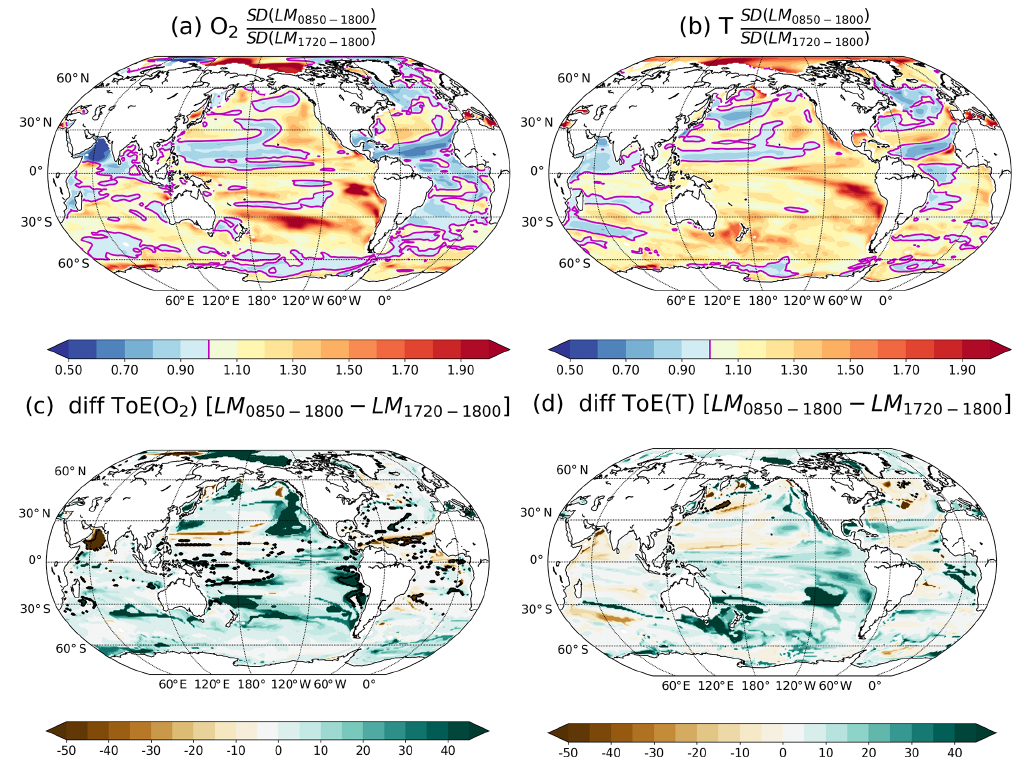
Figure A6. Ratio of the SDs of the forced simulation computed over the period 850–1800CE and over the period 1720–1800CE for (a) O 2 and (b) T . Difference of ToE using the SD of the forced simulation over the period 850–1800CE minus the ToE using the SD of the same simulation but over the pre-industrial period (1720–1800CE) for (c) O 2 and (d) T . The magenta contours highlight the ratio equal to 1, i.e. where SDs are equal. SDs are computed from annually and vertically averaged values between 200 and